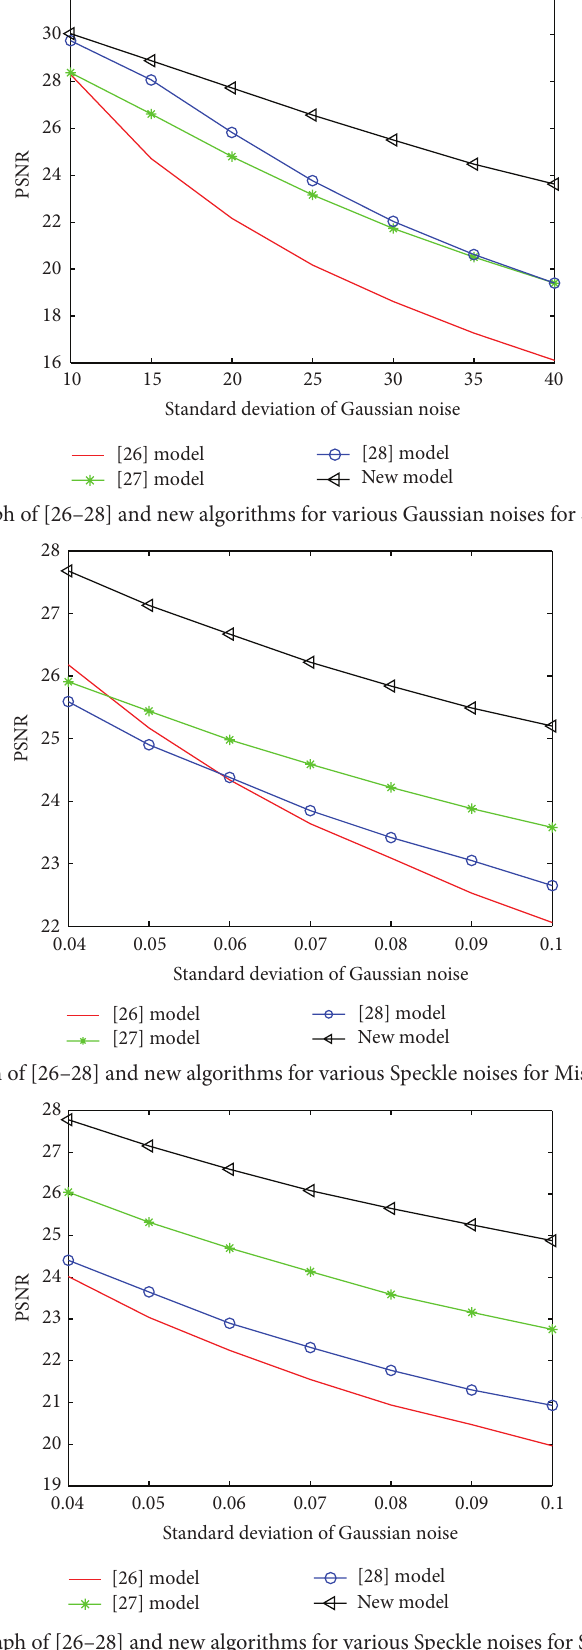
Figure 10: PSNR (dB) graph of [26–28] and new algorithms for various Speckle noises for Salesman video